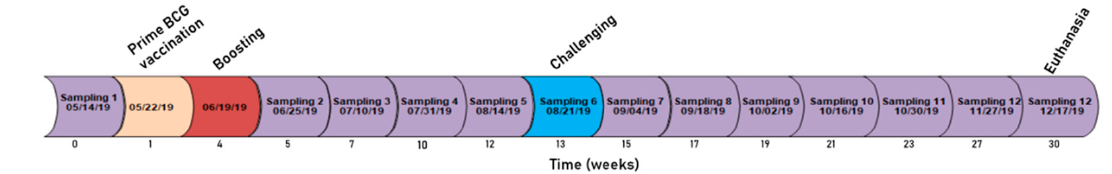
Figure 1. Dates of sampling, BCG prime vaccination, boosting, challenging, and euthanasia of vaccinated and nonvaccinated animals against tuberculosis in a goat model.